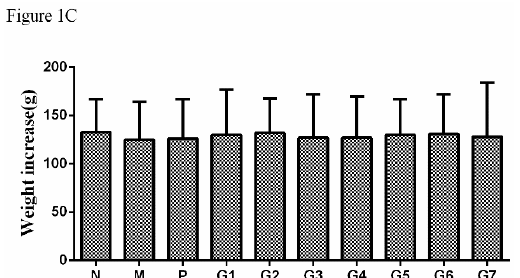
Figure 1C. The effect of glycyrrhizic acid (GA) on body weight (Figure 1C). N: normal group, M: model group, P: silybin positive group, G1:18 α -GA:18 β -GA = 10:0, G2:18 α -GA:18 β -GA = 8:2, G3:18 α -